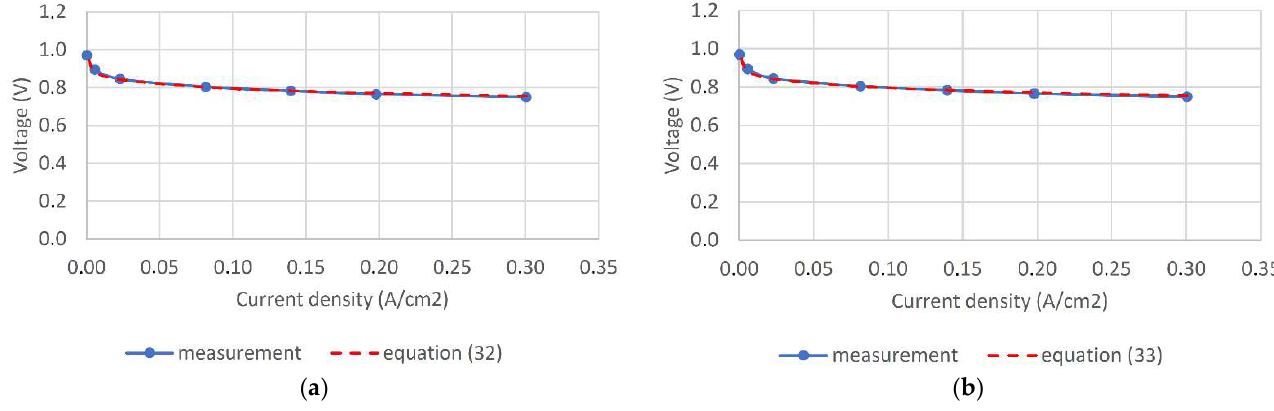
Figure 9. Measured polarization curve and its fitting curves: ( a ) fitting curve of Equation (31); ( b ) fitting curve of Equation (32).